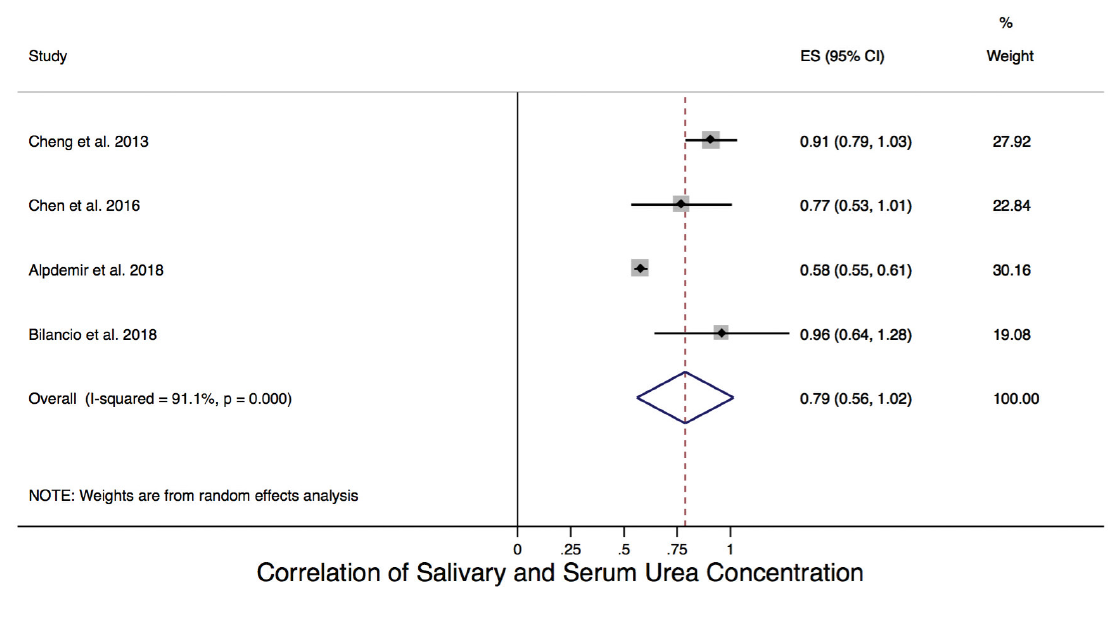
Figure 2A. Forest plot of the correlation between salivary and serum urea concentration. Weights are from random effects